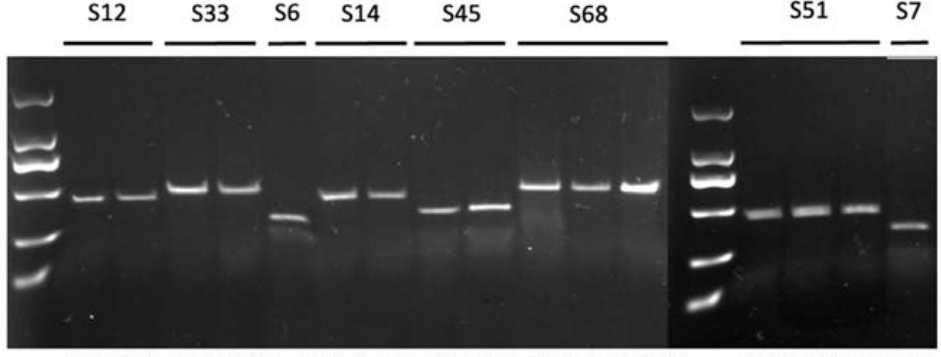
Figure 10. Image of agarose gel after the first digestion of 8 S ‐ haplotypes.